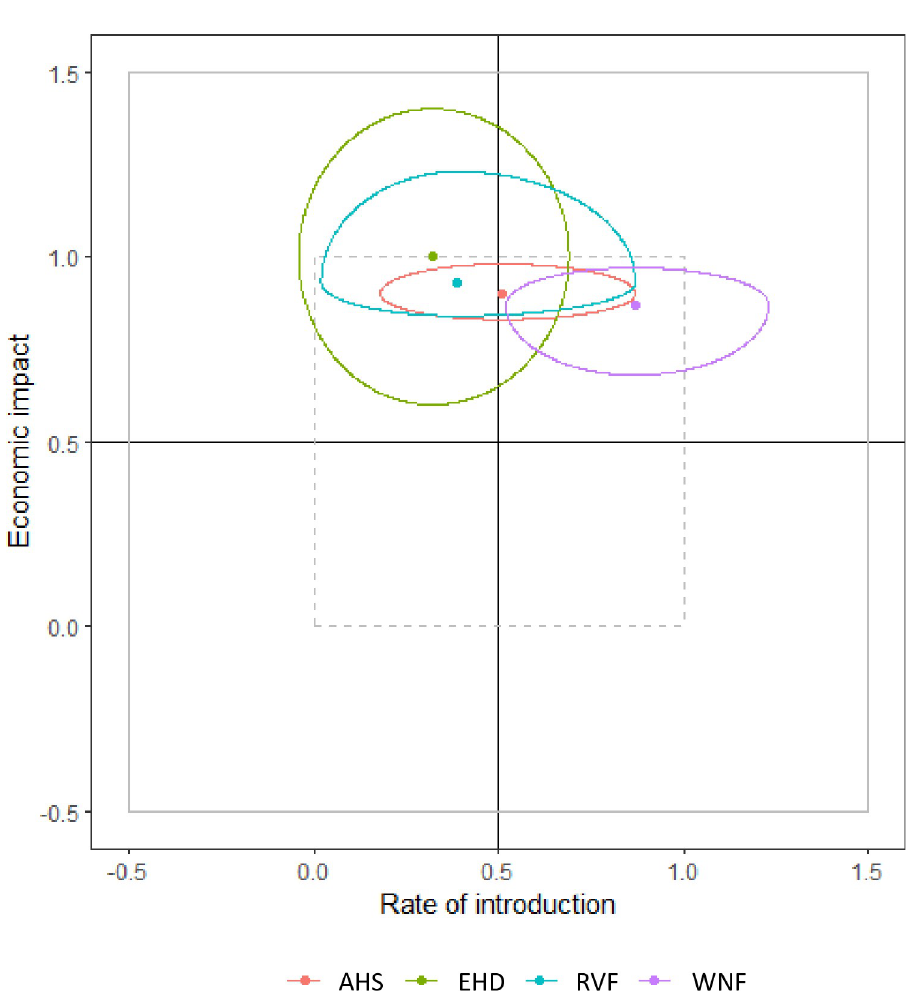
Fig 7. Risk profile diagram indicating how the rate of introduction and the economic impact contribute to the overall risk estimate. Dots indicate the median values for each disease with the lines enclosing the 95% uncertainty interval. Values outside the dotted square (i.e. beyond 0 and 1) indicate an extremely low ( < 0) or an extremely high ( > 1) risk. AHS = African horse sickness; EHD = epizootic haemorrhagic disease; RVF = Rift Valley fever; WNF = West Nile